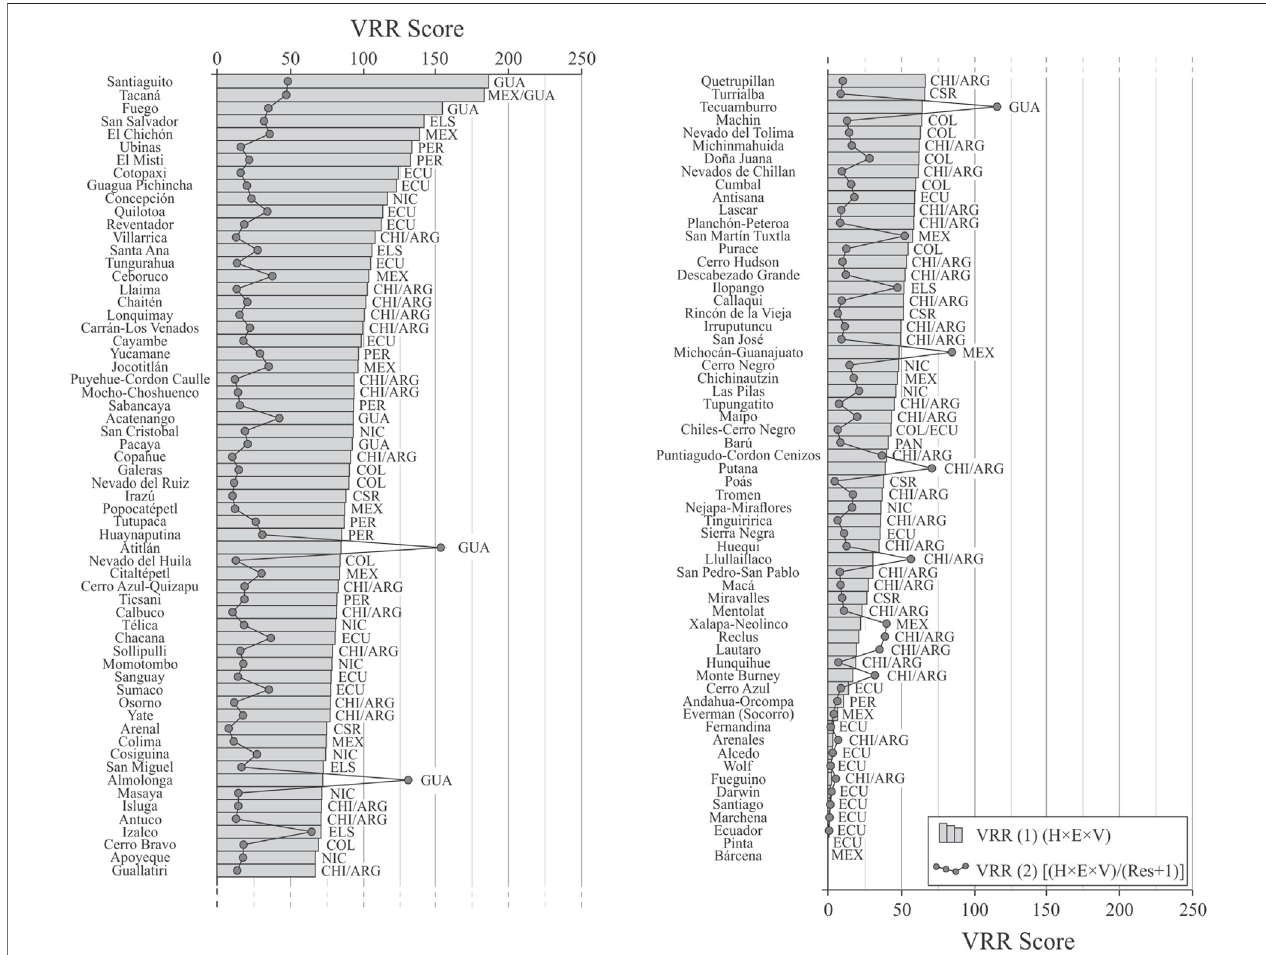
FIGURE8| LatinAmericaVRR(1)(lightgreyhistograms)andVRR(2)(darkgreycircles)consideringthesystemswithrecordedactivityinthepast1,000years.CHI/ ARG: Chile/Argentina; COL: Colombia; CSR: Costa Rica; ECU: Ecuador; ELS: El Salvador; GUA: Guatemala; MEX: México; NIC: Nicaragua; PER: Peru.